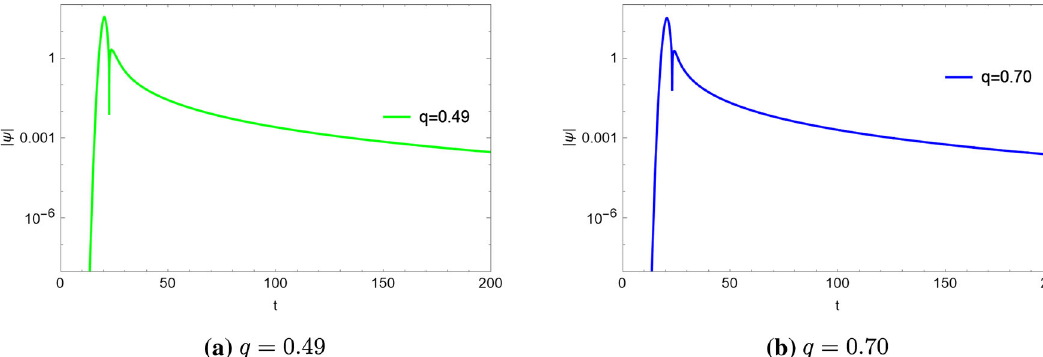
Fig. 6 In the left column, roots of (24) (blue solid line), (25) (green dottedline)and (26) (red dashedline)oftheasymmetricwormhole case in the HY metric. We set γ 1 = 1 ,γ 2 = 1 , Q = 1 , l = 0. Under these parameters, it represents the asymmetric wormholes for q > 0 . 2275